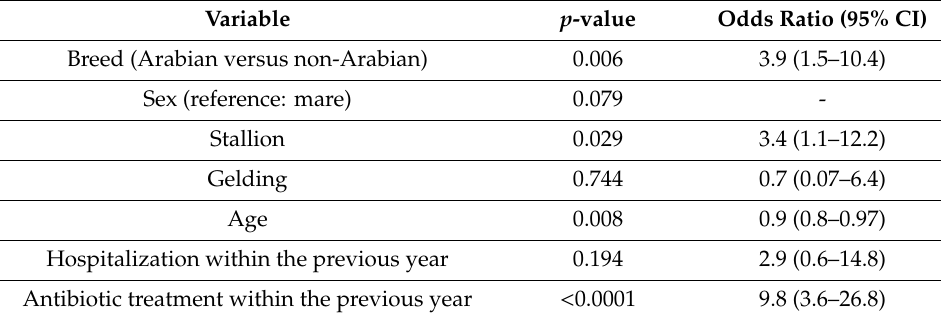
Table 4. Risk factor analysis for ESBL-E shedding by farm horses (logistic regression